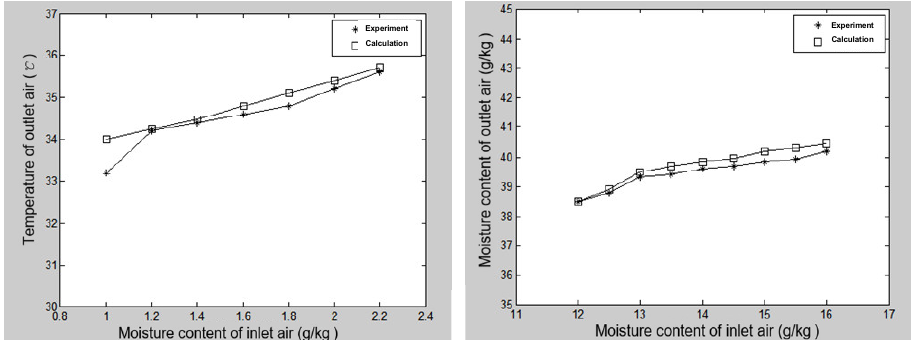
Figure 18. Comparison of calculated and experimental values of exit air temperature.